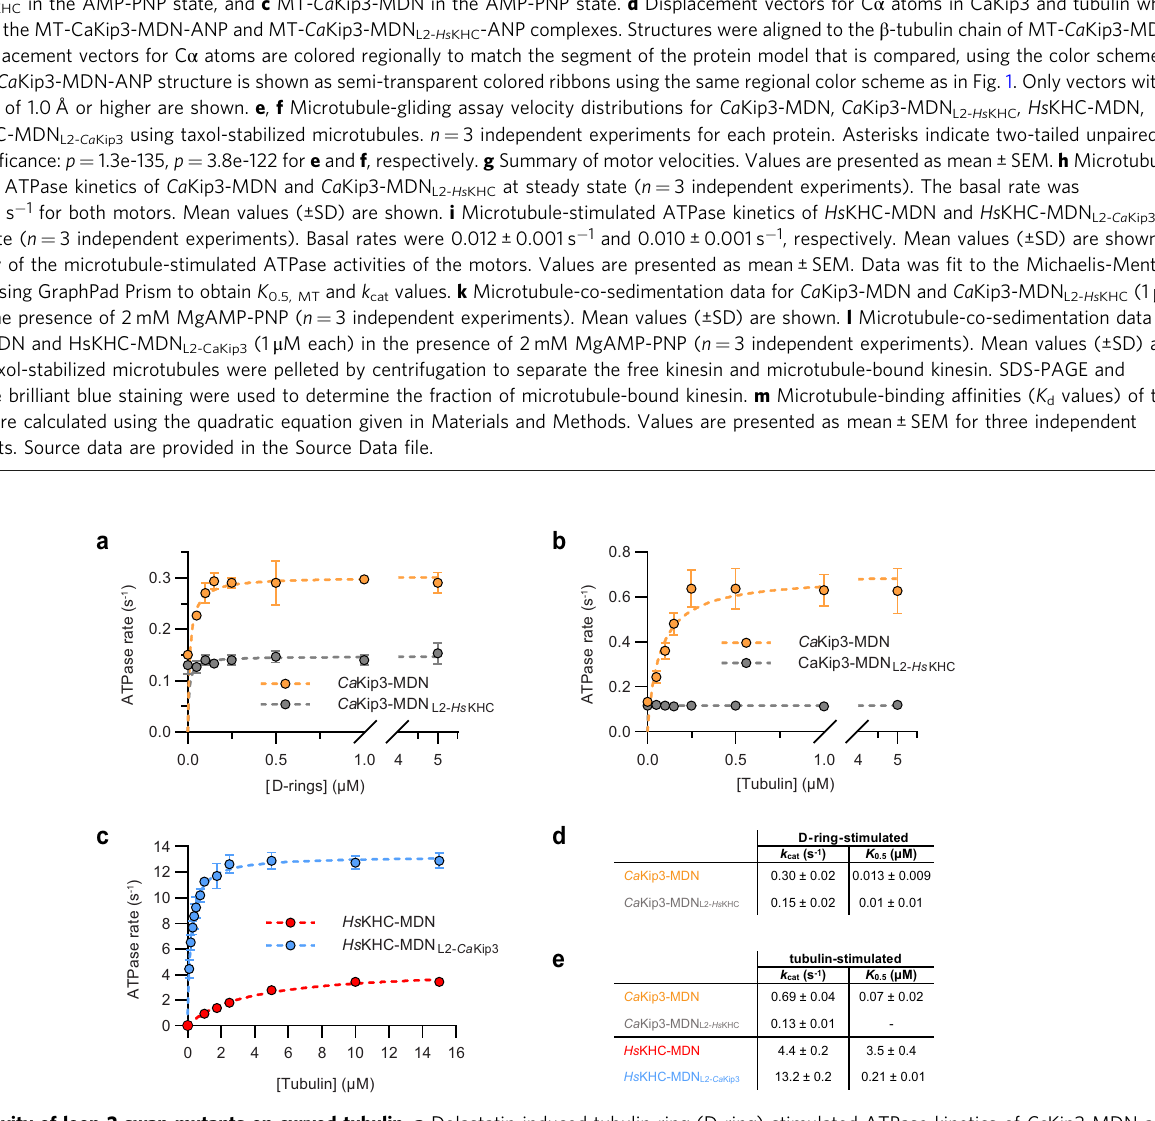
Fig. 5 Activity of loop-2 swap mutants on curved tubulin. a Dolastatin-induced tubulin-ring (D-ring)-stimulated ATPase kinetics of Ca Kip3-MDN and Ca Kip3-MDN n = 3 independent experiments). Mean values (±SD) are shown. b Free tubulin dimer-stimulated ATPase kinetics of L2- Hs KHC at steady state (